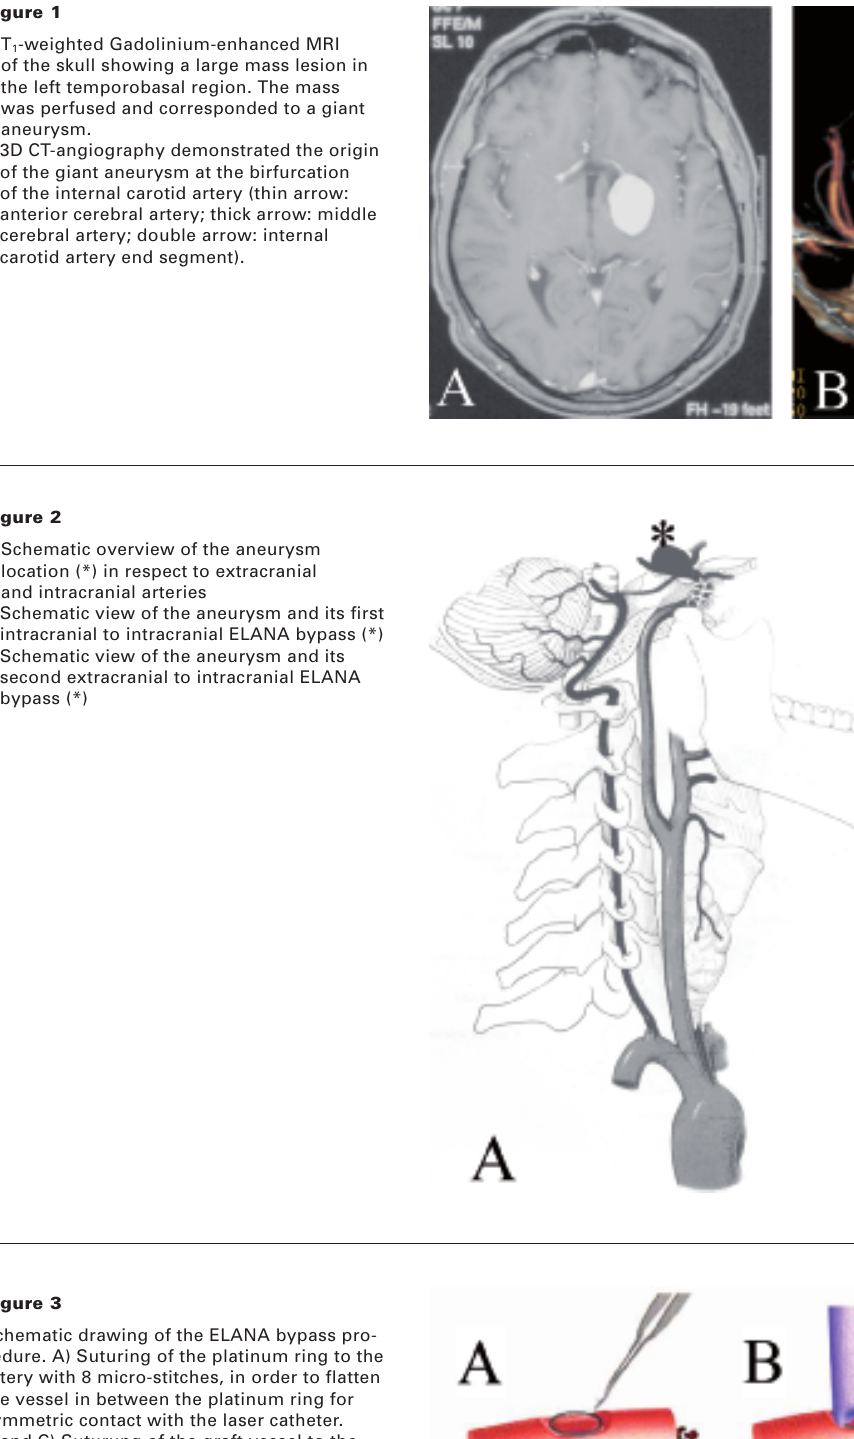
Schematic drawing of the ELANA bypass pro- cedure. A) Suturing of the platinum ring to the artery with 8 micro-stitches, in order to flatten the vessel in between the platinum ring for symmetric contact with the laser catheter. B and C) Suturung of the graft vessel to the platinum ring with another 8 micro-stitches. D) Introduction of the laser catheter into the graft vessel up to the platinum ring. E) Activation of the vacuum suction to aspirate the arterial vessel wall for improvement of the contact of the laser catheter. F) Activation of the laser catheter to punch out a flap into the vessel wall. G) Retrieval of the laser catheter and the aspirated vessel